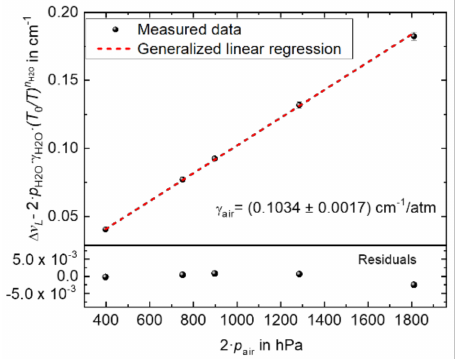
Figure 5. A GLR linear regression applied to measured data to determine the air broadening coefficient ( γ air) of the H 2 O line at 7299.43 cm − 1 at (295.04 ± 1) K. RMS error: 1.04 × 10 − 16 . The correlation coefficients between the x- and y-axis are assumed to be